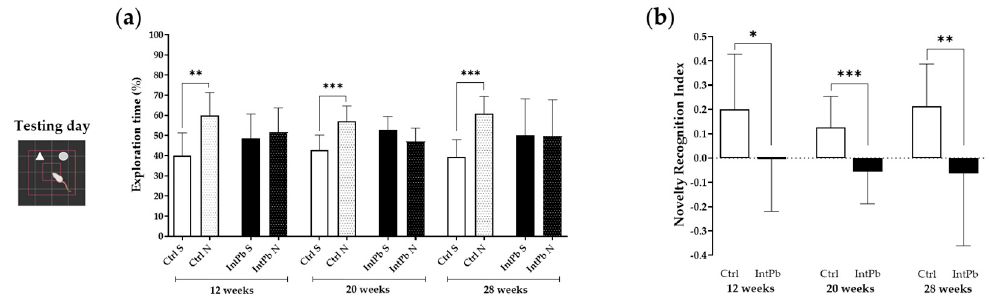
Figure 2. Episodic long-term memory assessed by novel object recognition test. ( a ) Percentage of exploration time of sample (S) and novel (N) objects by each group at the different time points. ( b ) Novelty recognition index is calculated by the equation presented in the Section 2. Values are expressed as the mean ± SD for n IntPb = 15 and n Ctrl = 18 for each evaluated time-point. Symbols denote statistically significant differences inter groups; * p < 0.05 ** p < 0.01, *** p < 0.001; paired Student’s t -test ( a ) and two-way ANOVA, Tukey’s multiple comparison test ( b